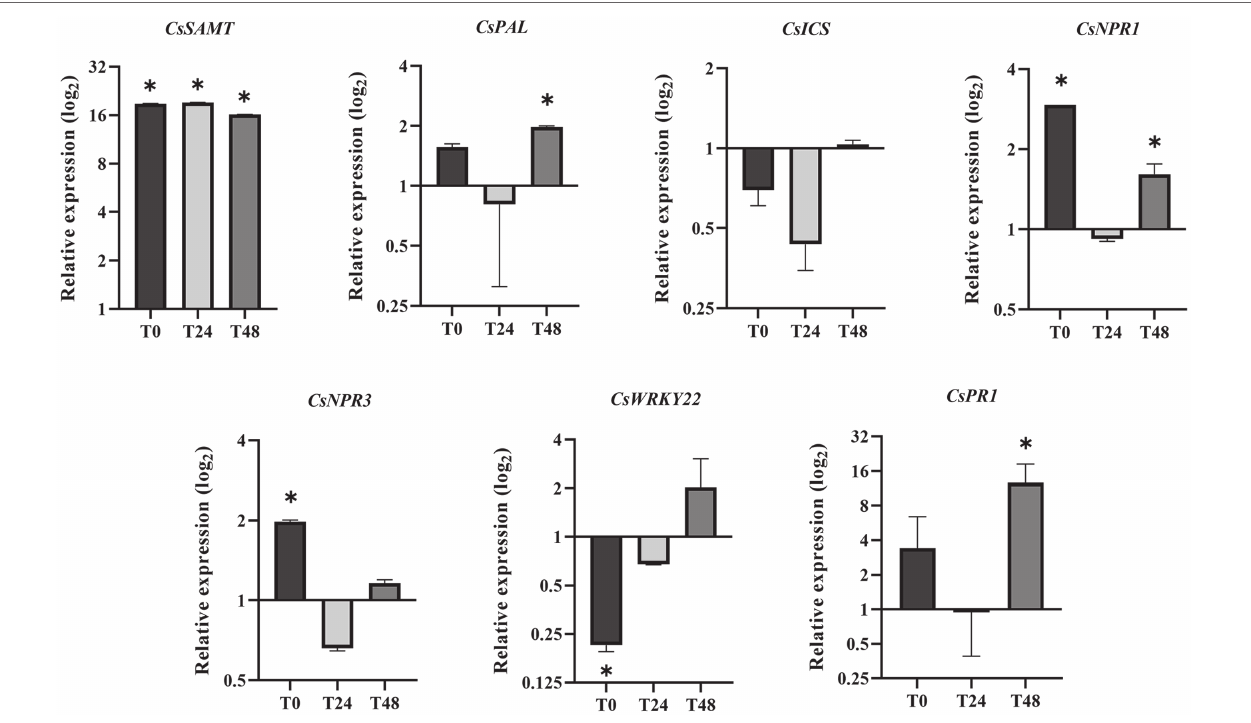
FIGURE 6 | Expression of defense-associated genes in VSAMT44 in relation to VWT at T0, T24, and T48 (see Figure 1 ). Three biological independent experiments were performed, and the statistical significance of the means was calculated according to Student’s t -test ( p <